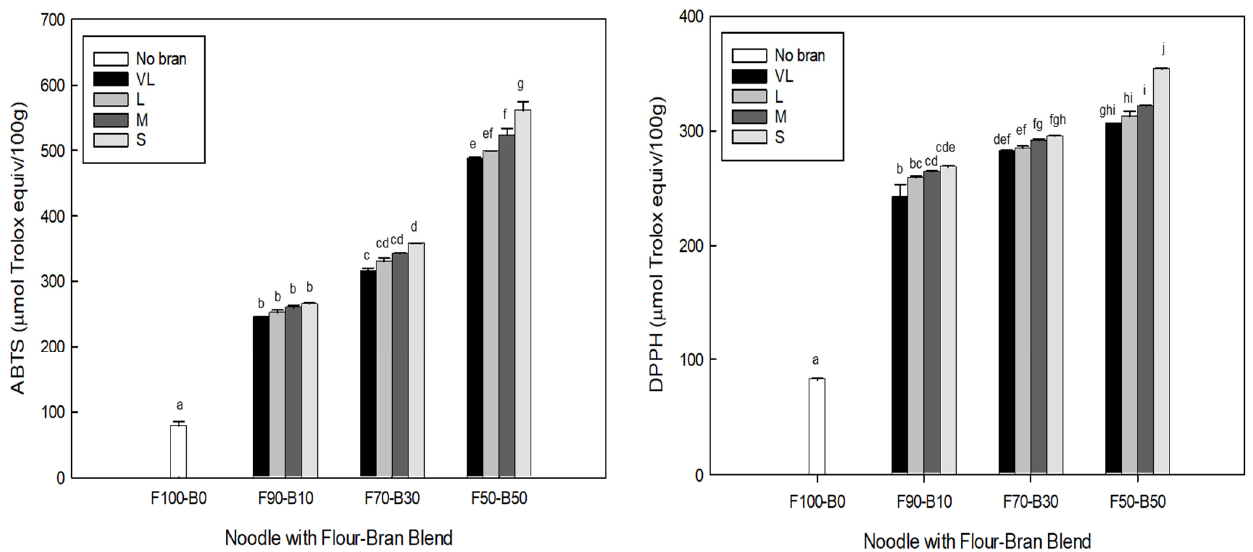
Figure 4. Antioxidant activity as indicated by ABTS and DPPH radical-scavenging activity of fresh noodles with flour-bran blends at different blending ratios and bran sizes. The different letters above the bars are significantly different ( p < 0.05) according to Tukey’s HSD test. VL, L, M, and S indicate the brans with very large, large, medium, and small particle